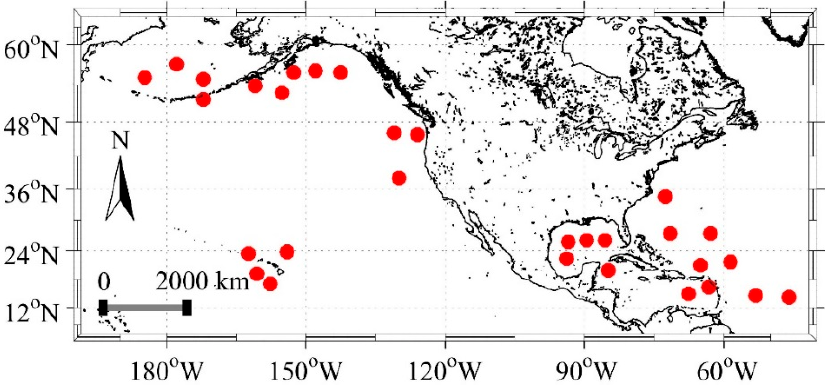
Figure 1. Locations of the 30 collocated National Data Buoy Center (NDBC) buoys.